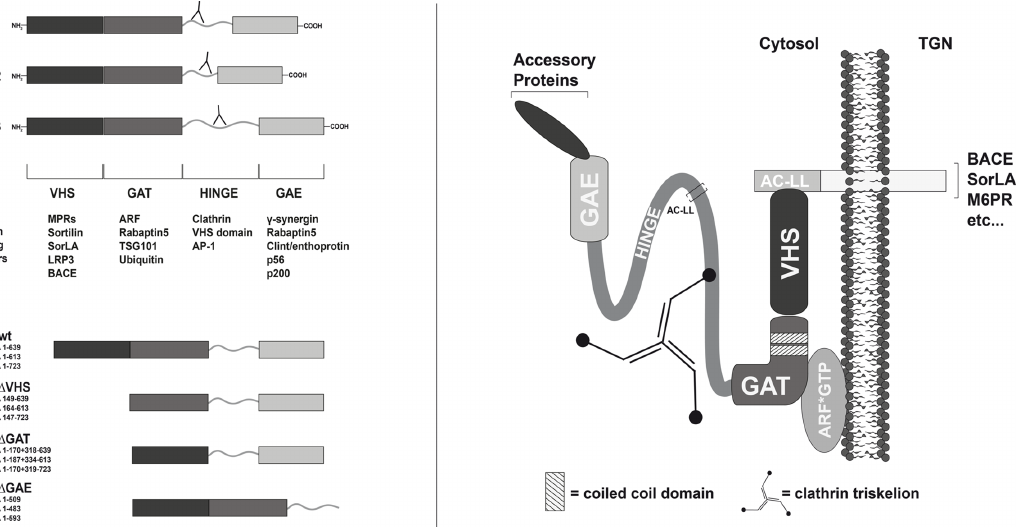
Fig 1. Human GGA protein family members. The GGA proteins were discovered almost simultaneously by five laboratories studying different aspects of membrane trafficking [14, 49 – 52]. The protein family consists of three members: GGA1, GGA2, and GGA3. GGAs are recruited from the cytosol onto the Golgi where they mediate the transport of cargo to endosomes/lysosomes. GGAs consist of four domains: the N-terminal VHS domain (Vps27, Hrs, and STAM); the GAT domain (GGA and Tom1), which contains two predicted coiled-coil domains; the hinge region, which contains one or more clathrin-binding sites; and the GAE domain (gamma-adaptin ear homology). The VHS domain is responsible for cargo recognition and binding via the AC-LL motifs in the cargo [6, 33, 53]. Membrane recruitment is provided by the GAT domain through ARF-GTP binding. Recently, the GAT C-terminal domains of GGA1 and GGA3 (but not GGA2) have also been shown to bind ubiquitin [54]. A distinct set of accessory proteins can bind to the GAE domain of GGAs, including rabaptin-5 [55], epsin R (Enthoprotin or Clint) [56 – 59], γ -synergin [14, 60], p56, and p200 [60]. Shown are the GGA deletion mutants used in this study (lower left panel). The antibodies used, directed against GGA1 (H215/Santa Cruz), GGA2 (BD), and GGA3 (BD), bind to the hinge regions of GGAs as indicated (upper left